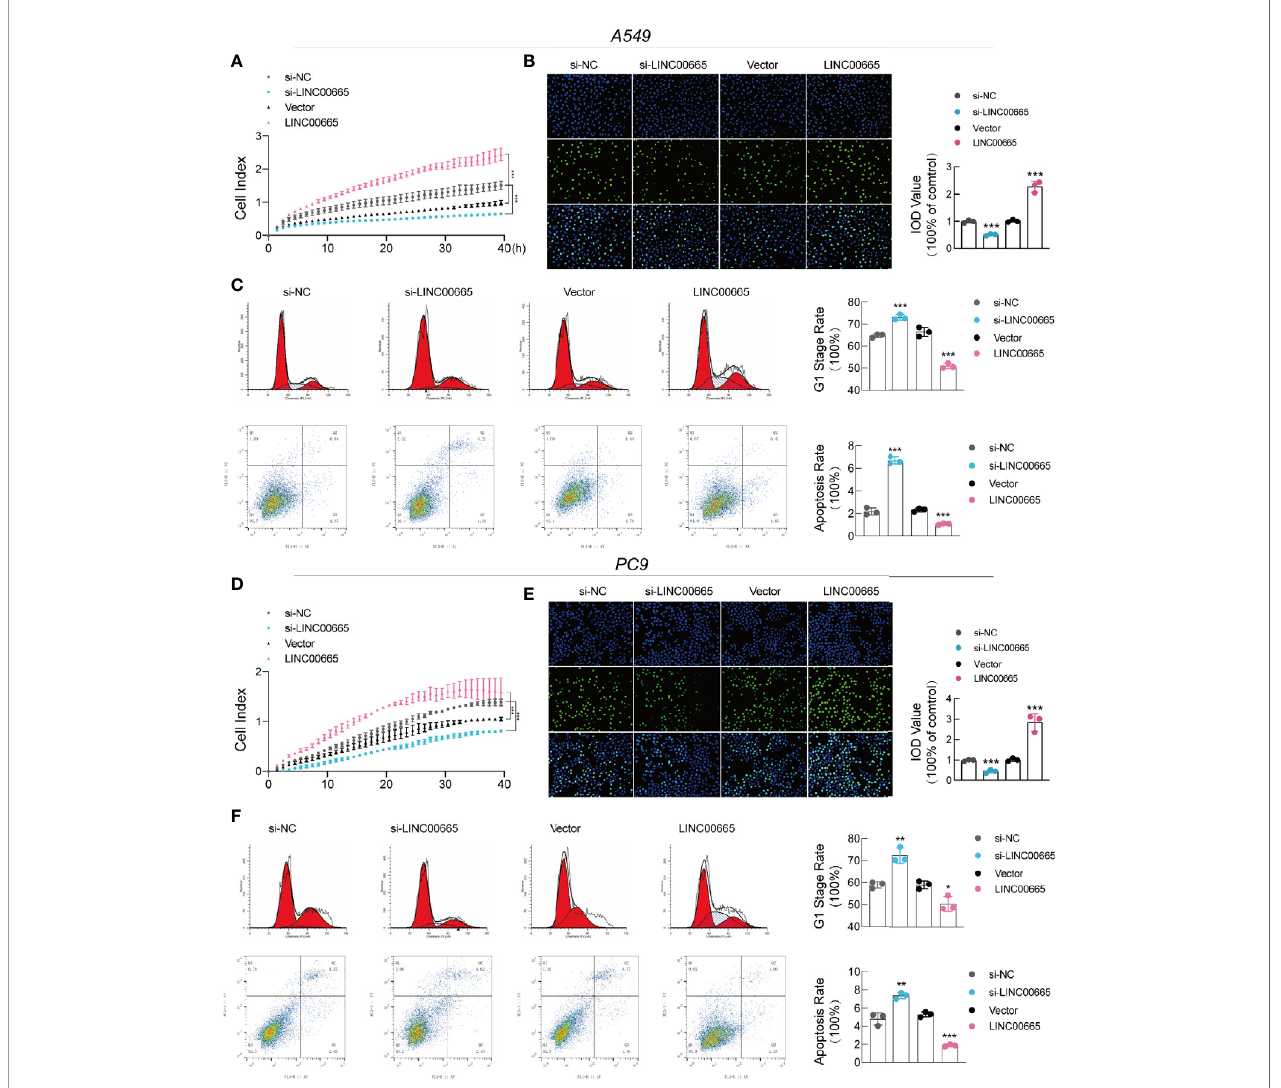
FIGURE 2 | LINC00665 promotes LUAD cell growth and induces cell cycle arrest and apoptosis in vitro. (A, B, D, E) RTCA and EdU assays of A549 and PC9 cells with LINC00665 knockdown or overexpression. (C, F) Cell cycle and cell apoptosis rate of A549 and PC9 cells that received the indicated treatments analyzed with FACS. *p < 0.05; **p < 0.01; ***p <